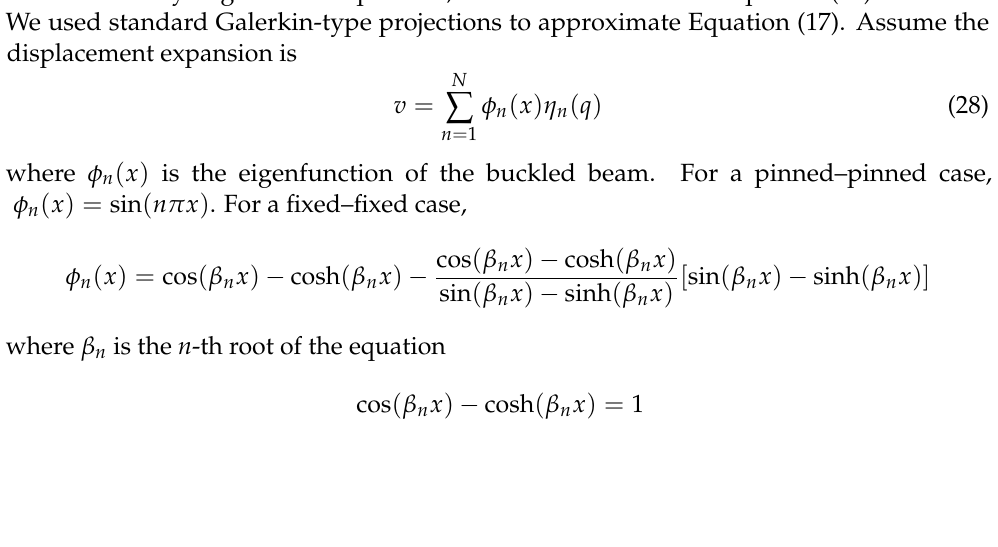
Figure 4. The first supercritical natural frequencies for a pinned–pinned case.